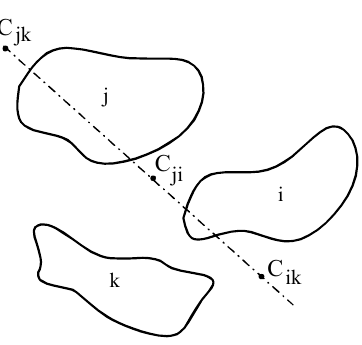
Figure 1. Diagram of the Aronhold-Kennedy theorem.